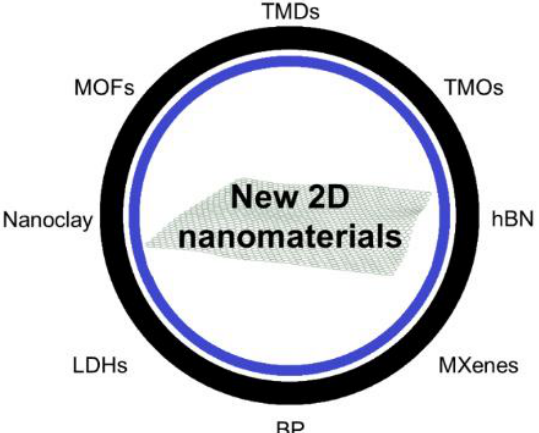
Figure 1. Summary of new 2D nanomaterials beyond graphene. These include transition metal dichalcogenides (TMDs); transition metal oxides (TMOs); hexagonal boron nitride (hBN); transition metal carbides, nitrides and carbonitrides (MXenes); black phosphorus (BP); layered double hydroxides (LDHs); nanoclay; 2D metal-organic frameworks (MOFs).